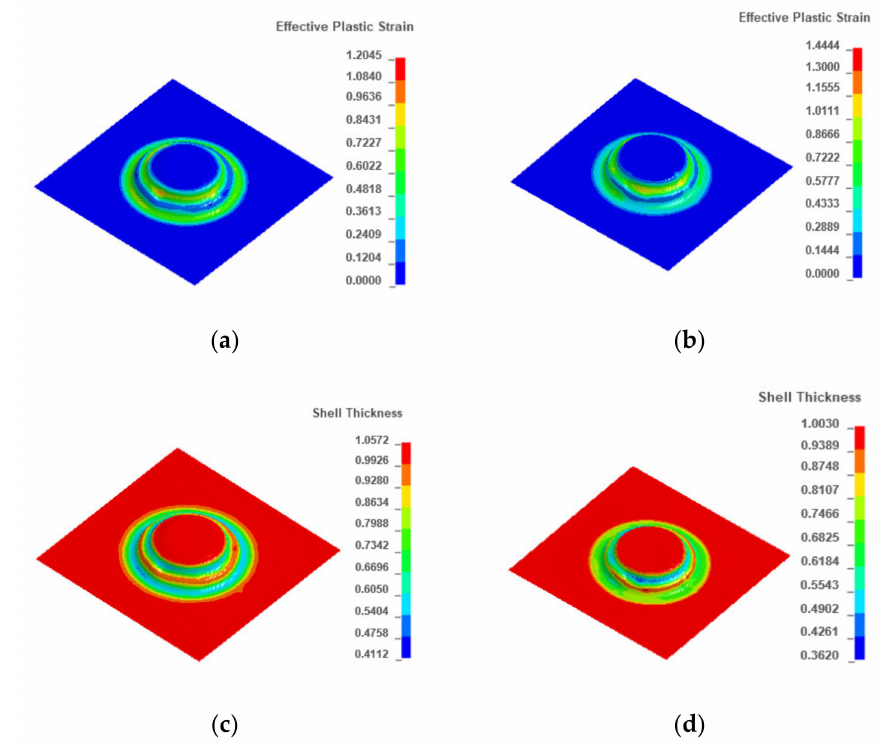
Figure 14. Optimal simulation result and the reference: ( a ) e ff ective strain contour using optimal process parameters, ( b ) e ff ective strain contour of the reference, ( c ) thickness contour using optimal process parameters, and ( d ) thickness contour of the